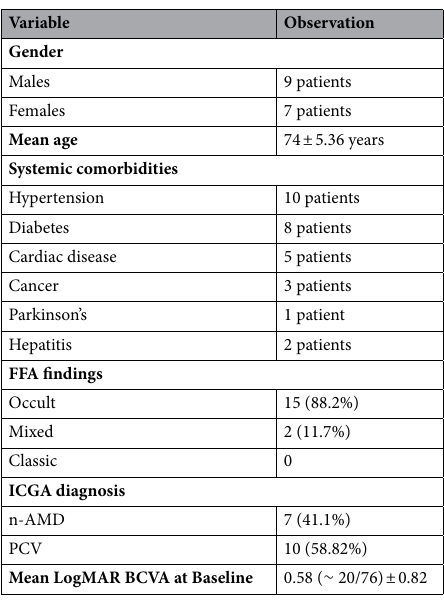
Table 1. Baseline patient profile, systemic findings, and angiographic results. FFA: Fundus fluoresceine angiography; ICGA: Indocyanine green angiography; n-AMD: Neovascular age-related macular degeneration; PCV: Polypoidal choroidal vasculopathy; BCVA: Best corrected visual acuity; CFCF: Counting finger close to face.